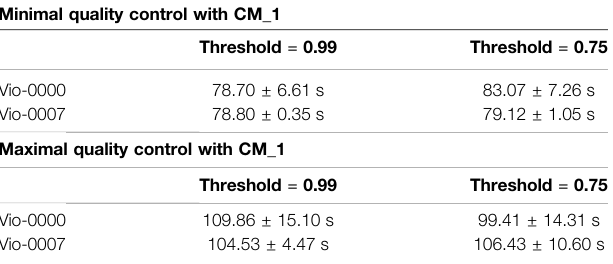
TABLE 1 | Performance of the CM_1 Algorithm. Performance was assessed for constructs of opposite complexity and different reconstruction thresholds. Results in the top part of the table for the minimal QC scenario show computation times do not depend on the constructs and threshold. Results in the bottom part of the table for the maximal QC scenario show similar results.